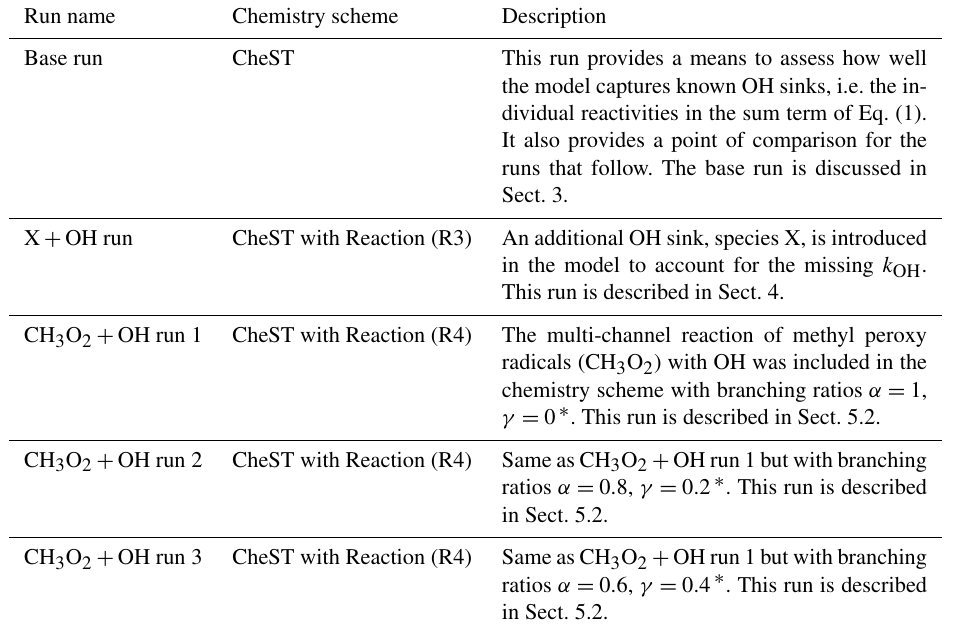
CH 3 O 2 + OH run 3 CheST with Reaction (R4) Same as CH 3 O 2 + OH run 1 but with